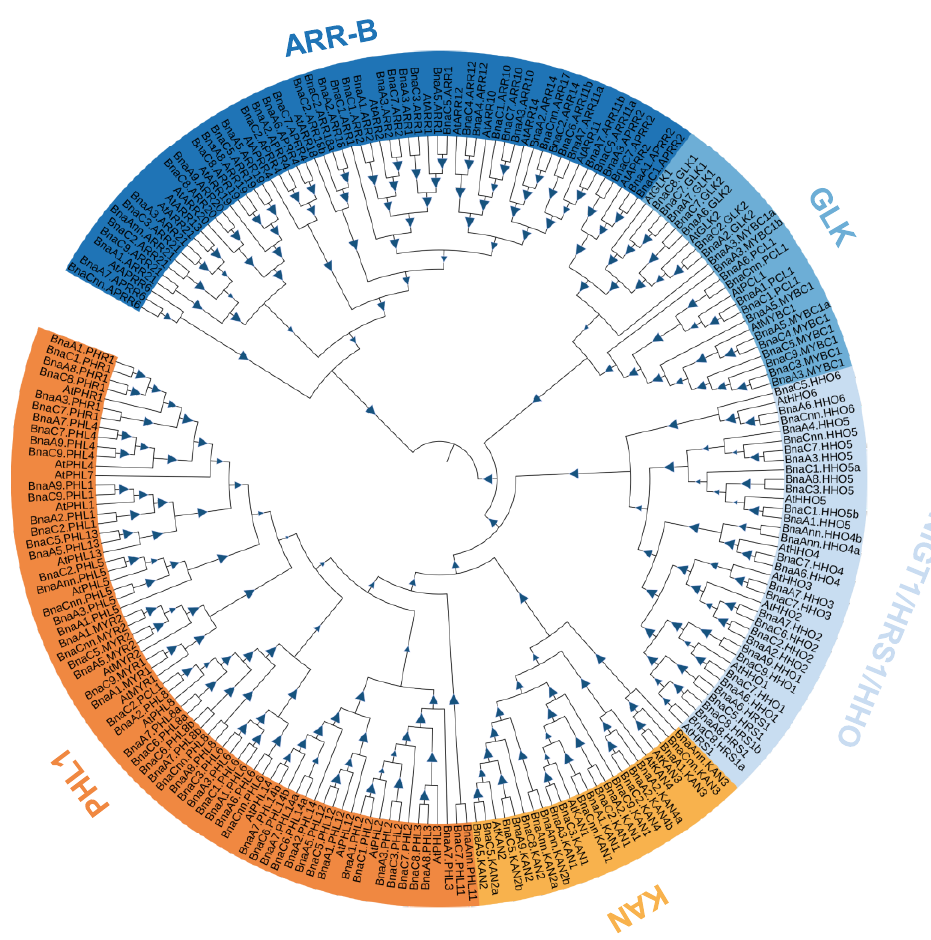
Figure 1. Phylogenetic tree of the GARPs retrieved from B. napus and A. thaliana . The phylogenetic tree was constructed according to the neighbor-joining method. The tree was generated using MEGA7.0 based on the GARP amino acid sequences retrieved from B. napus and A. thaliana . The genes from each group are indicated by different colors. The rectangle sizes at the nodes represent the bootstrap values.